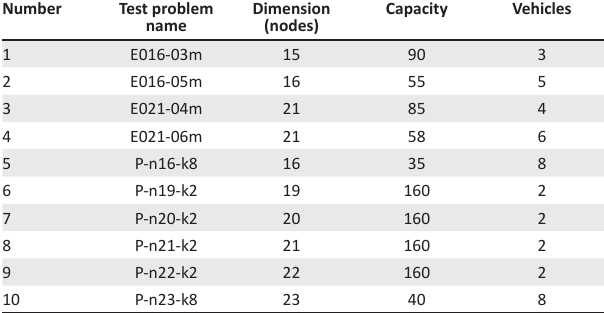
TABLE 1: Considered Capacitated Vehicle Routing Problem Test Problems for adaptation. Number